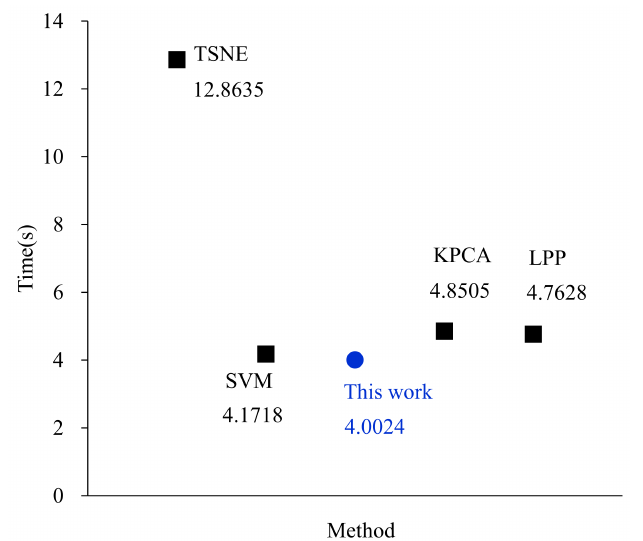
Figure 14. The calculation time of different data dimensionality reduction methods (TSNE, SVM, KPCA, LPP, and this work).